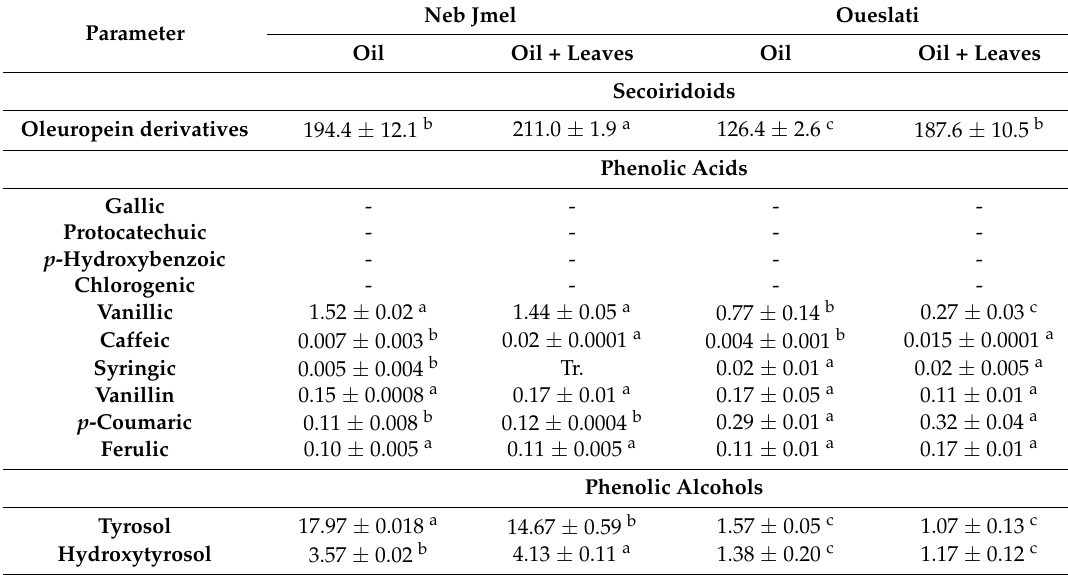
Table 4. Phenolic compounds (mg/kg) of Neb Jmel and Oueslati olive oils extracted with and without addition of olive leaves